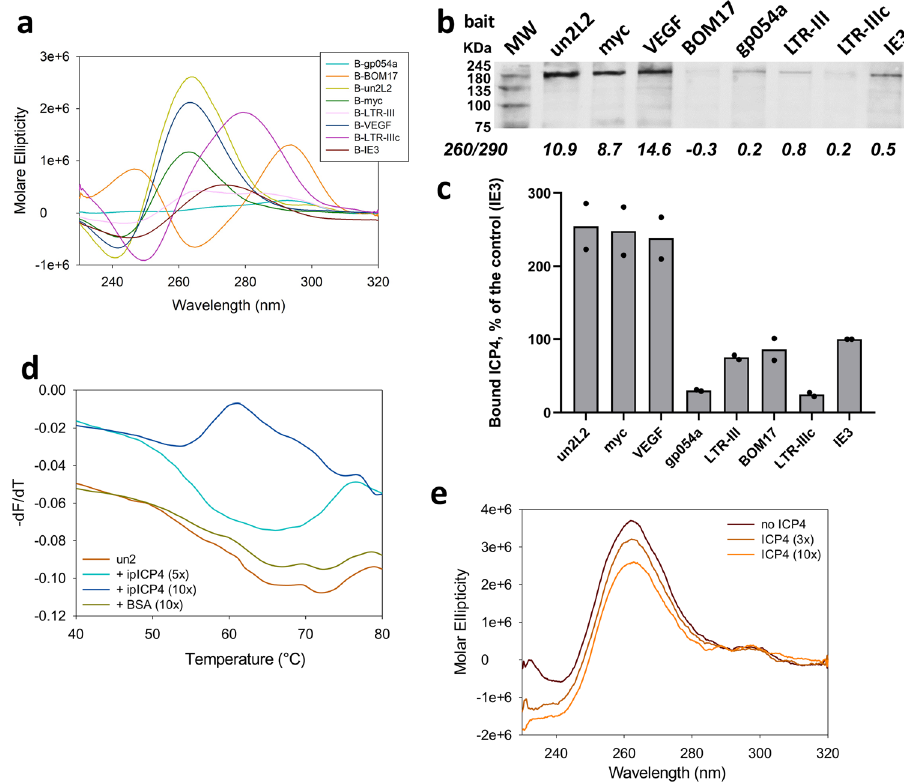
Fig. 1 ICP4 binding and unfolding of G4-folded oligonucleotides. a CD spectra of the biotinylated oligonucleotides used in the cross-linking-pull-down assay, folded in potassium phosphate buffer (20 mM PB, 80 mM KCl). Spectra were acquired from two independent experiments with two replicates each; spectra from one measurement are shown. b Western blot analysis of ICP4 binding to the indicated G4s (parallel: un2L2, myc and VEGF; antiparallel BOM17; mixed gp054a and LTR-III; non G4 LTR-IIIc; ICP4 consensus binding sequence: IE3). Infected cell nuclear extracts (5 µ g) were incubated with formaldehyde-activated G4-folded oligonucleotides; proteins bound to the G4s were eluted after high stringency washes. ICP4 was detected using the anti-ICP4 antibody. MW molecular weight (Marker VI, Applichem). Below the gel image, the 260/290 ratio for each biotinylated oligonucleotide is displayed. c Quanti fi cation of ICP4 bound to the G4s in (b) is indicated in the bar chart (average of two independent experiments, each oligo was tested in one replicate per experiment, SD is displayed). Band quanti fi cation was normalised for the fraction of ICP4 bound to its consensus sequence (IE3). d